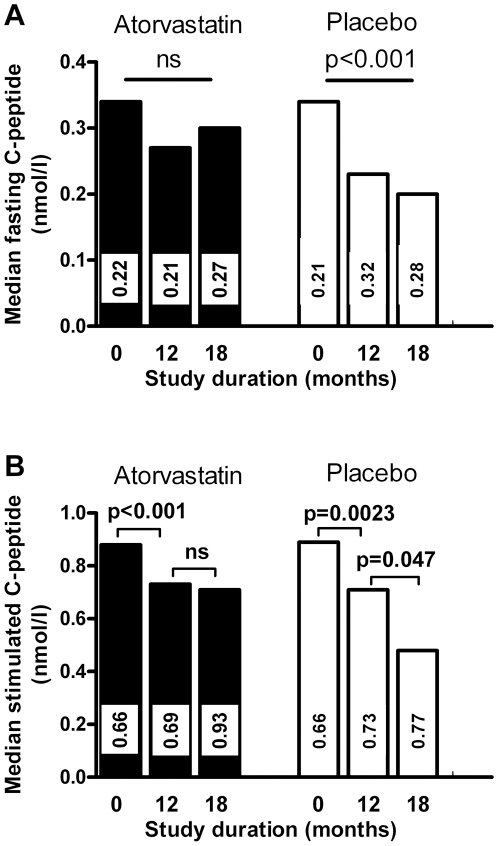
Course of C-peptide secretion in the study groups.Fasting serum C-peptide concentrations (a) were the mean of
two blood samples obtained 5 min apart, samples for stimulated serum
C-peptide (b) were obtained 90 min after a standard liquid
mixed meal. Numbers in columns indicate the IQR. Filled bars,
atorvastatin, empty bars, placebo. Differences between groups were not
significant. Comparison between groups by Mann-Whitey-u-test, within
groups by Wilcoxon signed rank test.